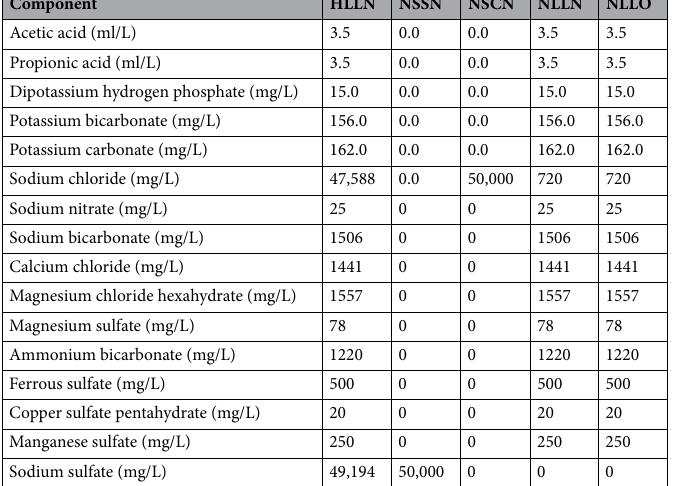
Table 1. Composition ratio of landfill